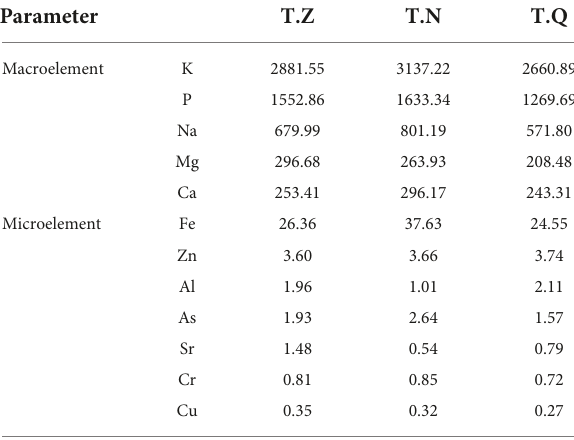
TABLE 5 Mineral content of three hairtail muscles (mg · kg − 1 , w/w).